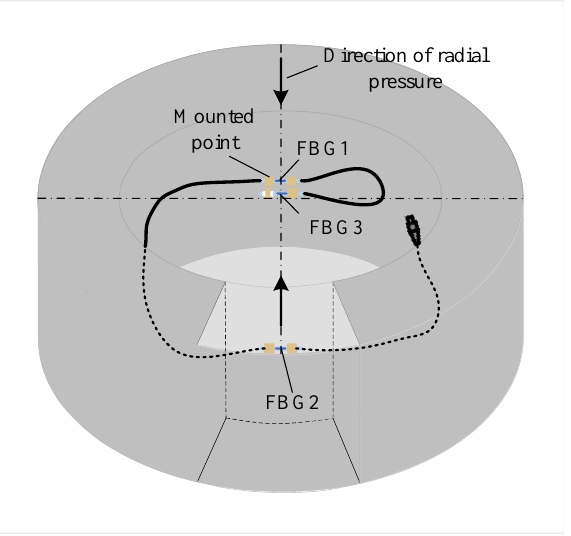
Figure 2. Diagram of strain detection of the structure with